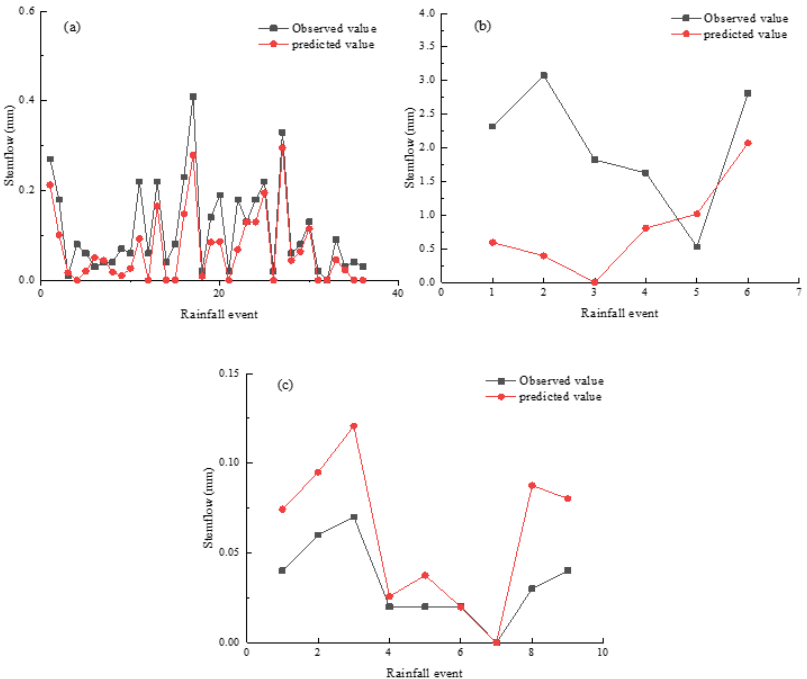
Figure 7. Comparison of individual observed and predicted stemflow. ( a ): Rainfall pattern A; ( b ): rainfall pattern B; ( c ): rainfall pattern C.